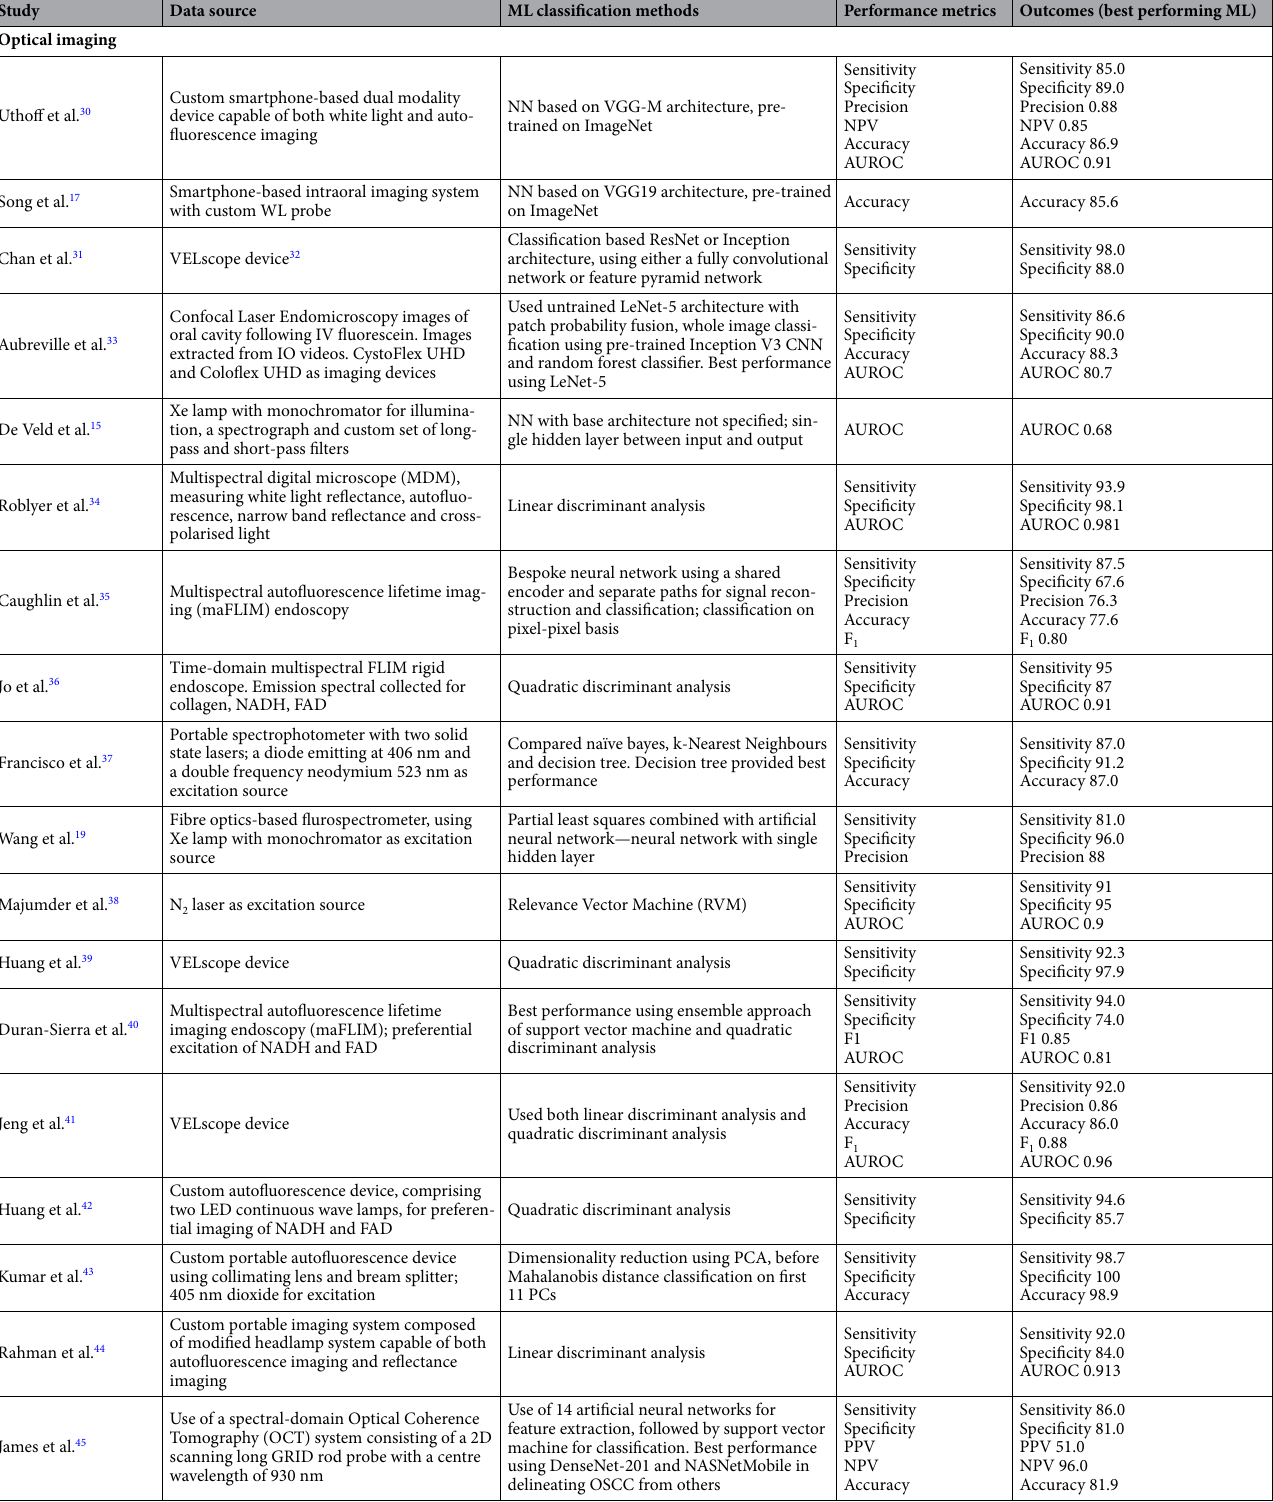
Table 2. Summary of identified studies using optical imaging as the screening